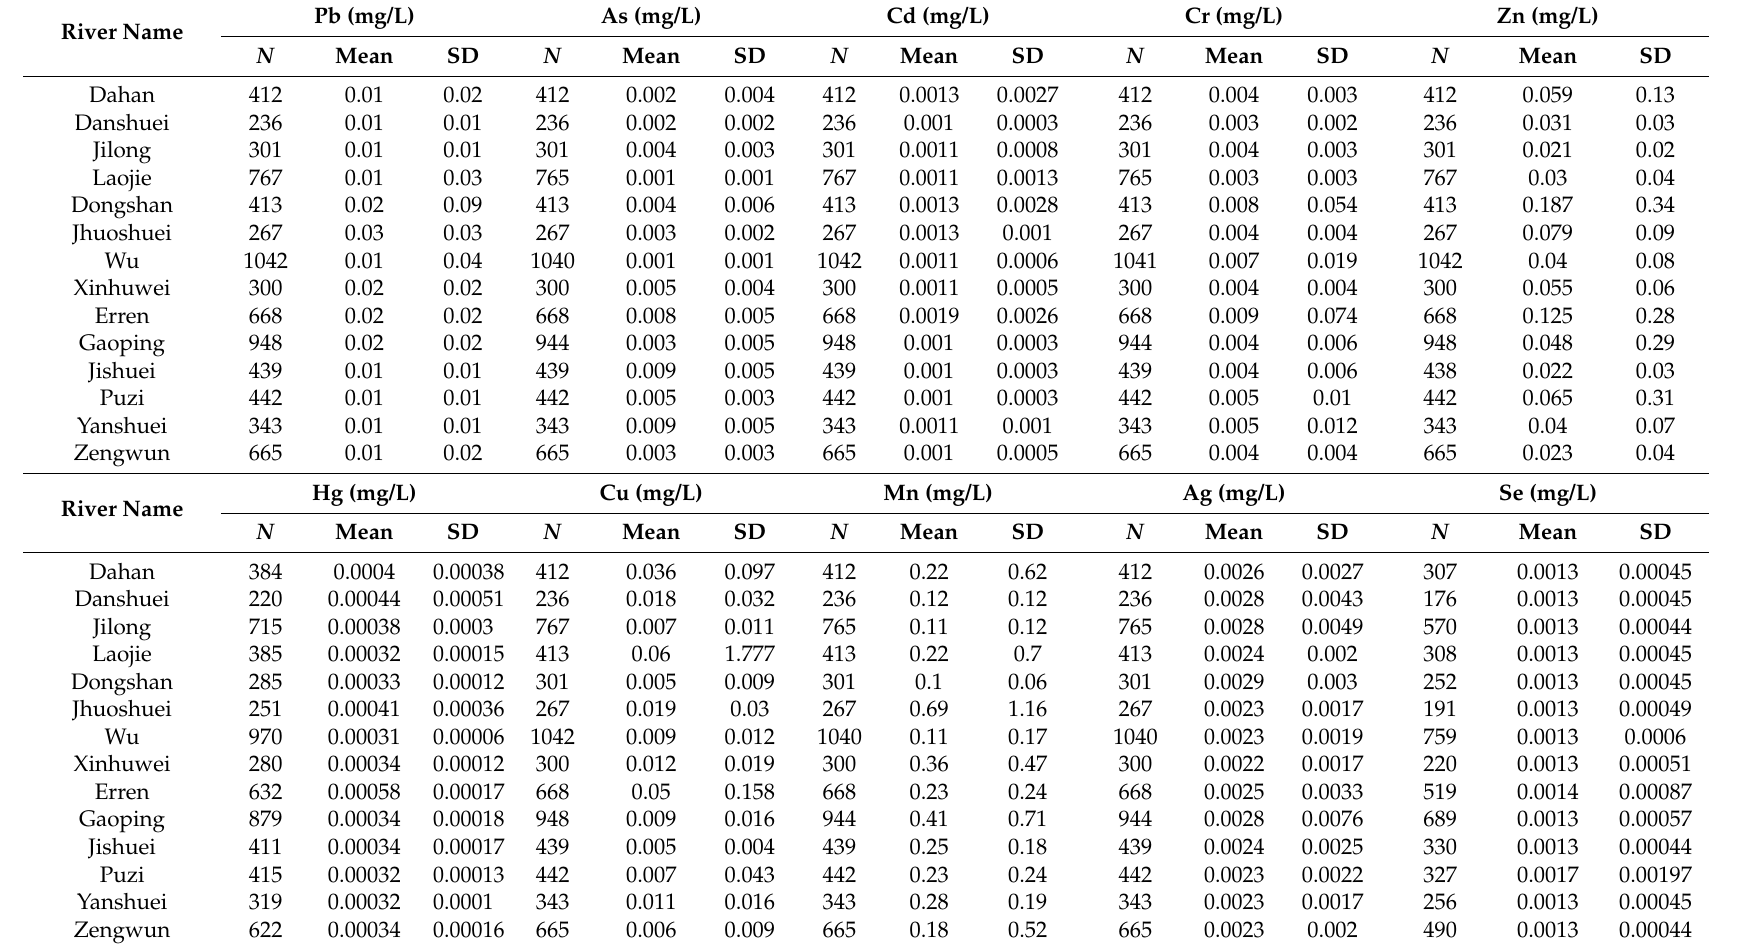
Table 2. Descriptive statistic of heavy metals in 14 Taiwan representative rivers between 2002 and